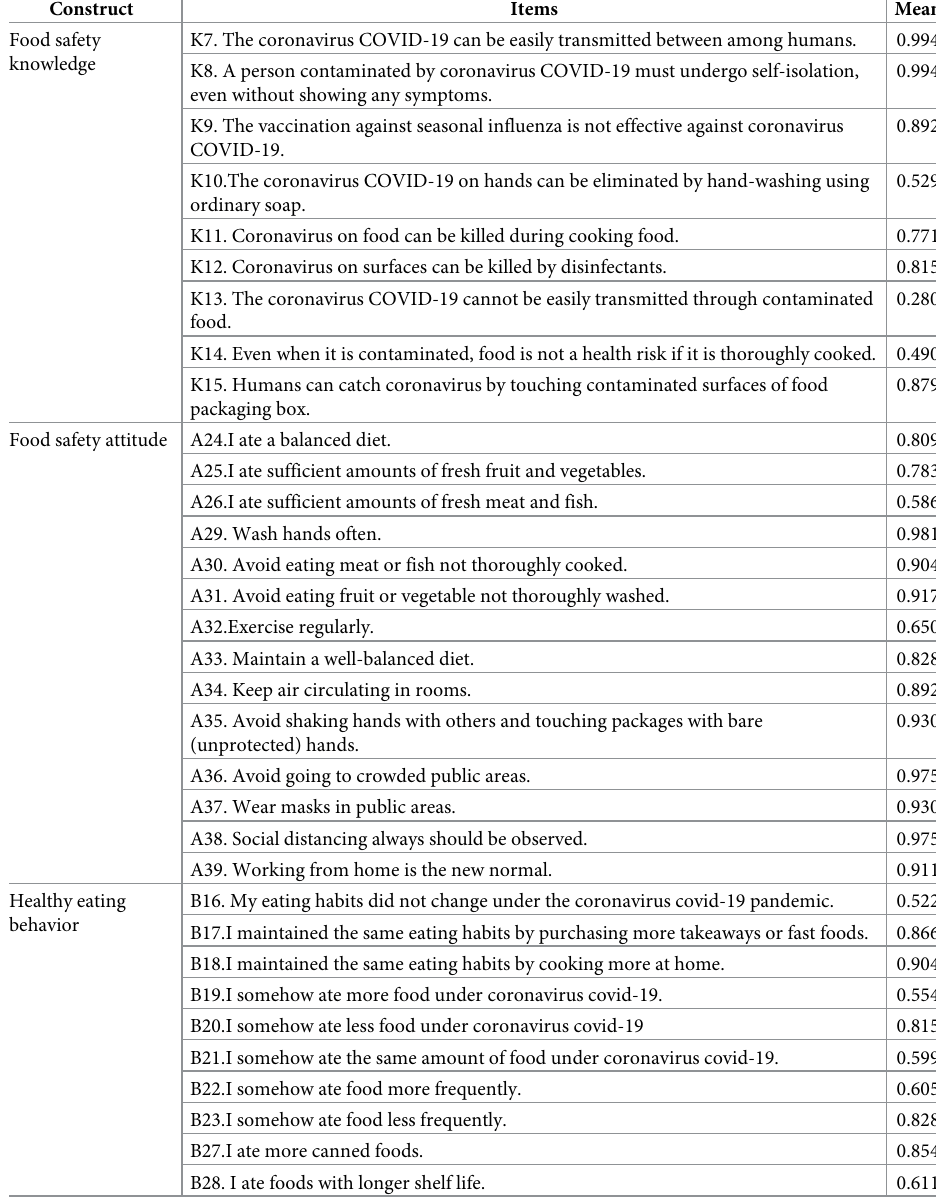
Table 4. Mean scores of items in food safety knowledge, attitude, and behavior. Construct Items Mean Food safety